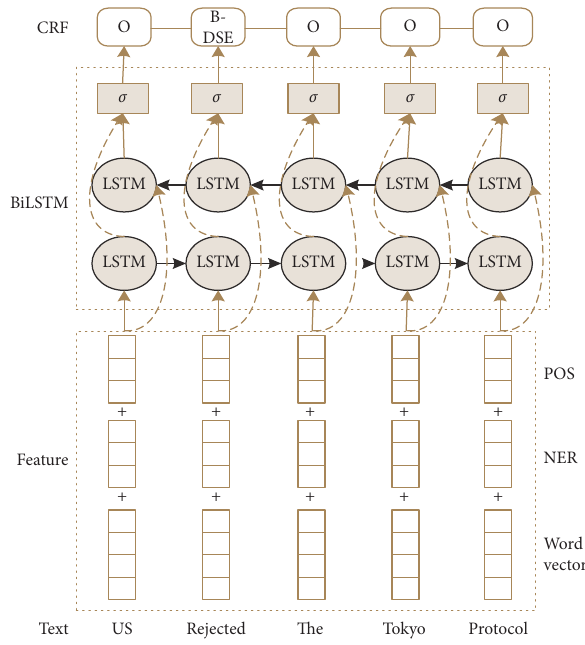
Figure 4: Model architecture